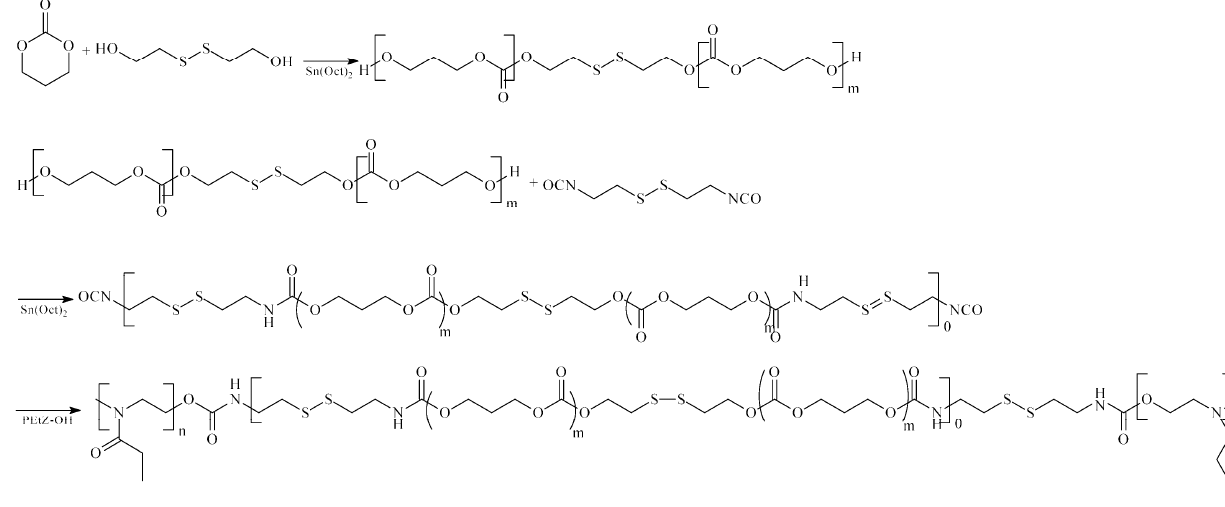
Figure 7. Synthesis of the pH and redox dual stimuli-responsive polyurethanes.